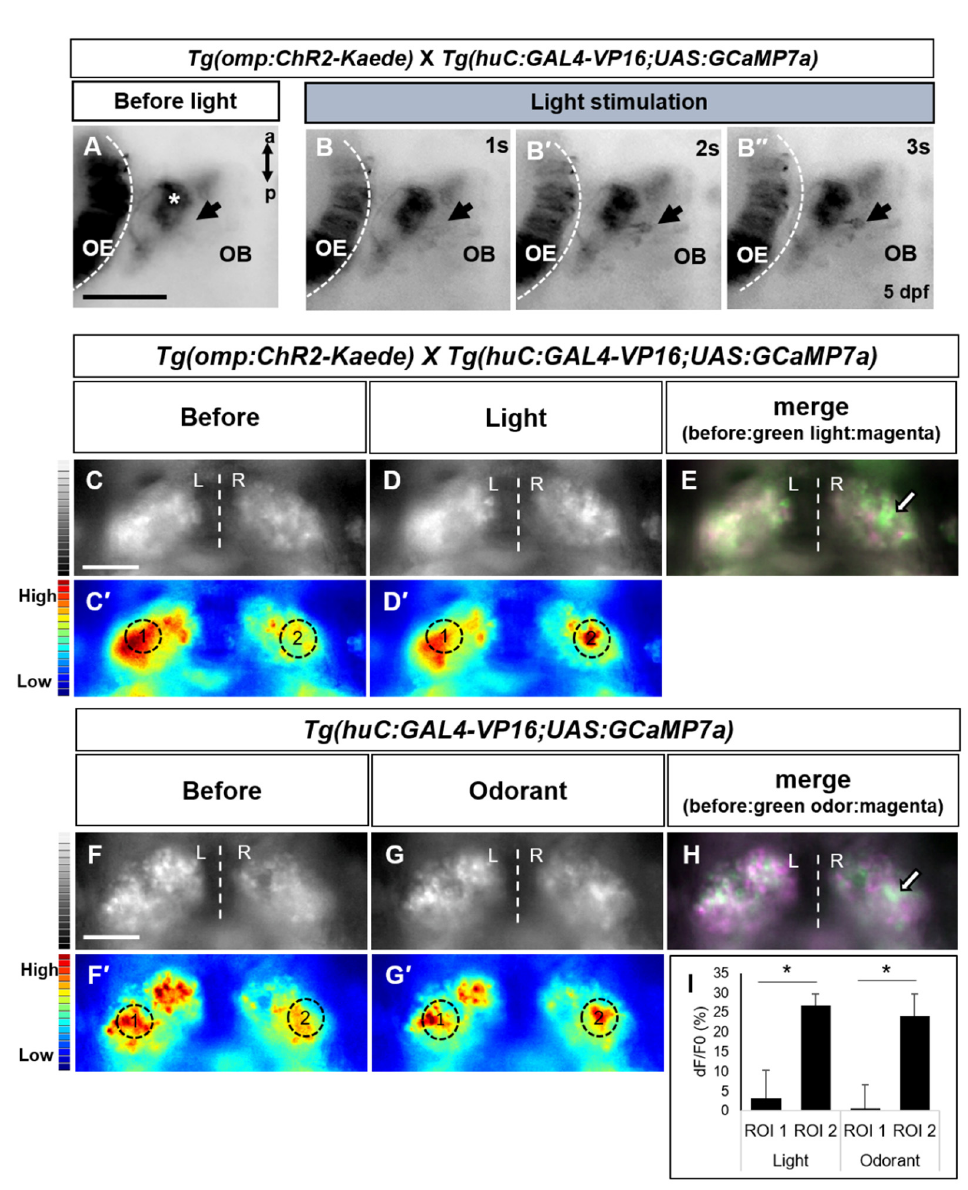
Figure 3. Analysis of calcium transient in olfactory bulb and habenula evoked light/odor stimuli. ( A ) Olfactory epithelium (OE) and olfactory bulb (OB) of transgenic fish before light irradiation. ( B , B ′ , B ′′ ) After light stimulation, calcium signals were detected in olfactory bulb. Asterisk indicates axon terminals of olfactory sensory neurons and arrow indicates newly emerging cell bodies by optical stimulation. a, anterior; p posterior. Scale bar: 50 μ m. ( C – H ) Odor responses of habenula in transgenic zebrafish lines. ( C – D ′ ) In Tg(omp:ChR2-Kaede);Tg(huc:GAL4-VP16;uas:GCaMP7a) , habenular neuron responses to light. (F – G ′ ) Odorant evoked habenular response in Tg(huc:GAL4- VP16;uas:GCaMP7a) . Cells before stimulated were colored in magenta, and cells responding to